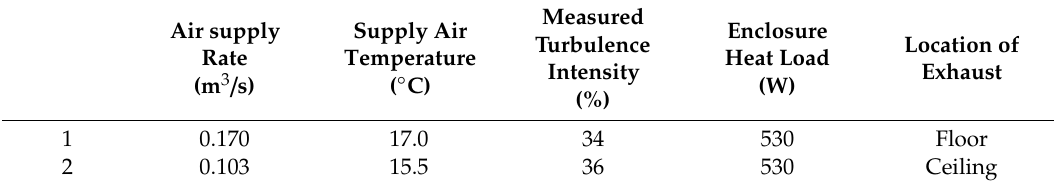
Table 2. The experiment conditions of Wang and Chao [29].